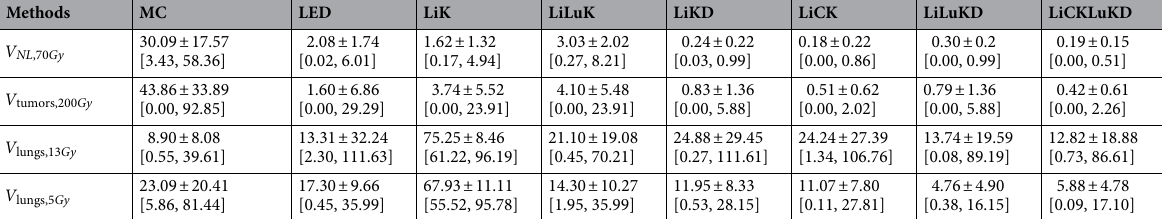
Table 4. Absolute percent differences of DVH dosimetrics using VSV methods compared with MC and the dosimetrics calculated by MC. Mean ± std, [min, max].